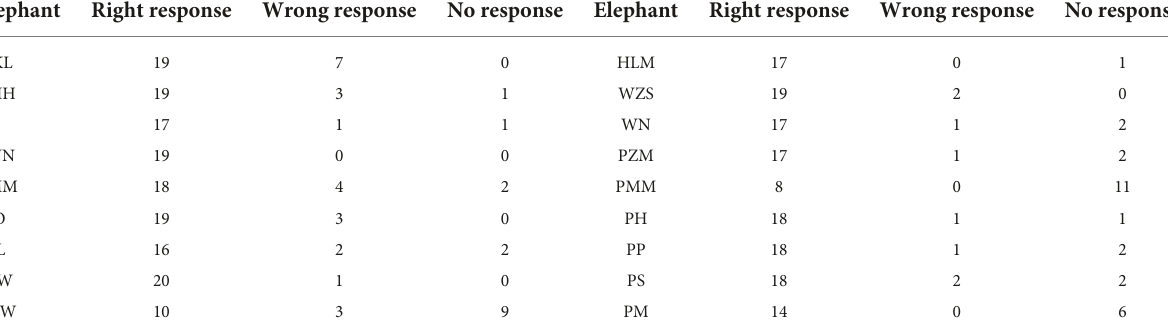
TABLE 3 The frequency of right, wrong, and no responses of each elephant tested in this study. Elephant Right response Wrong response No response